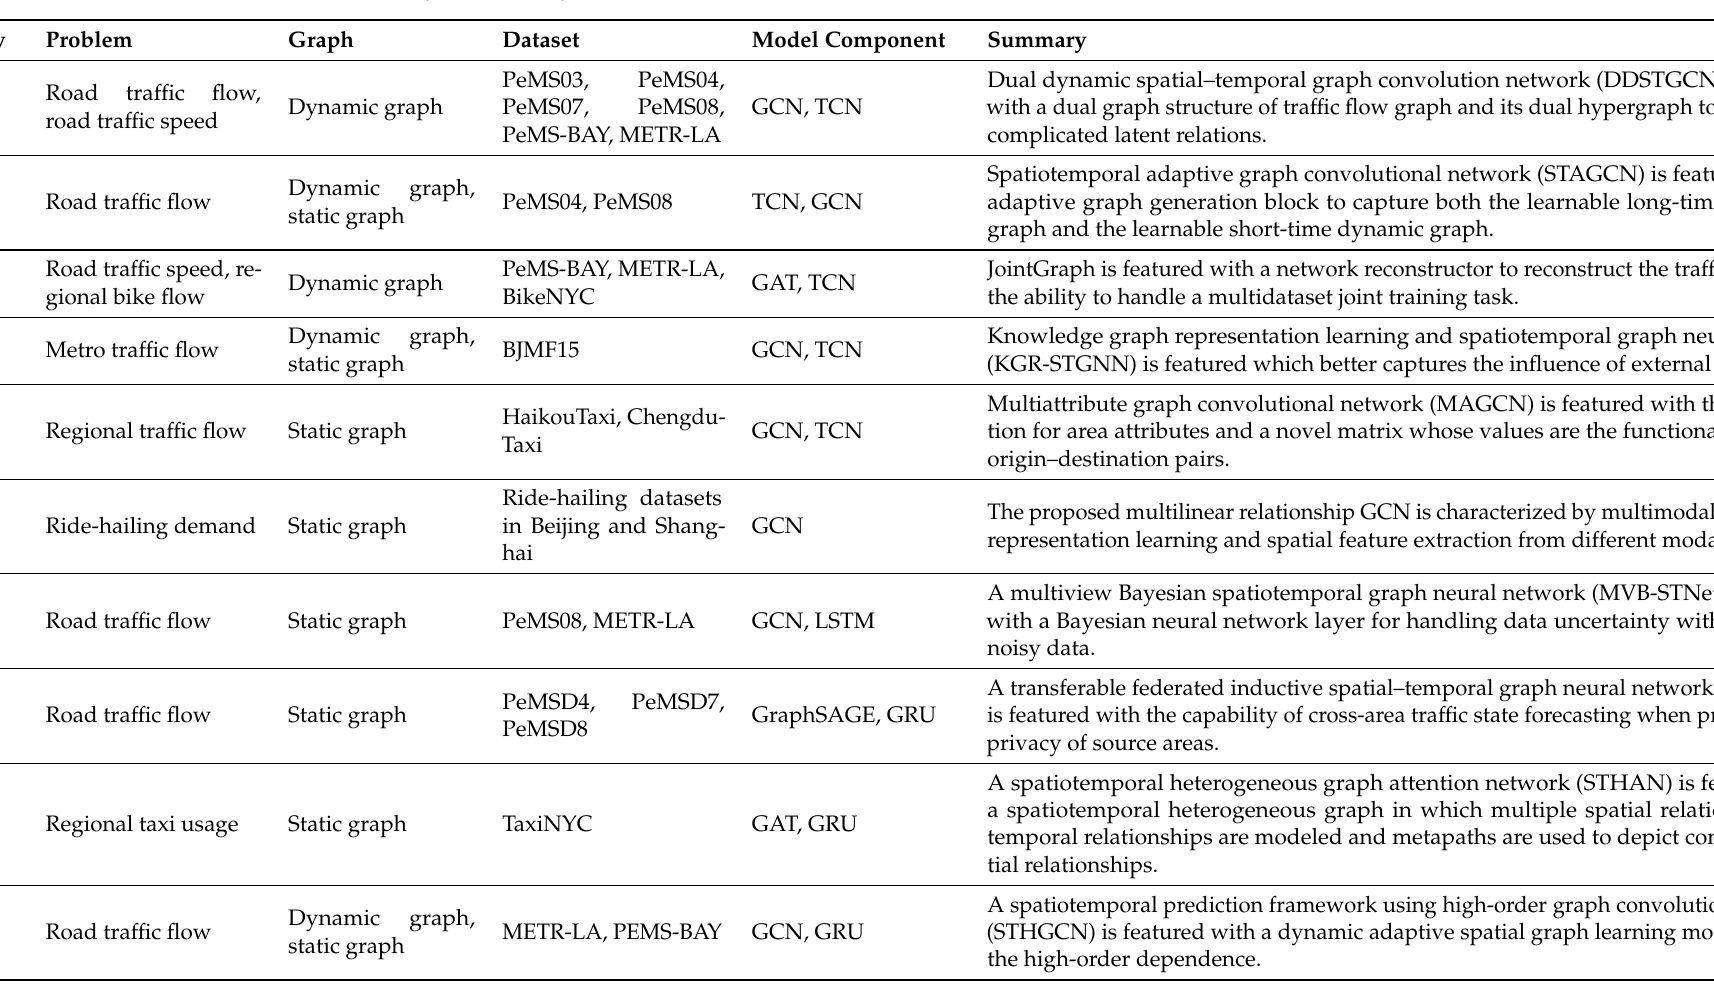
Table 1. Summary of the surveyed